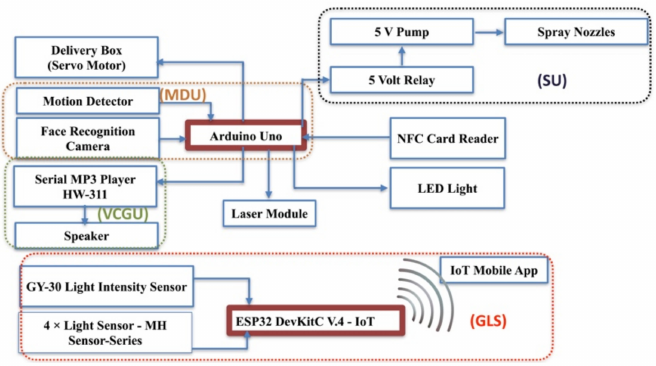
Figure 5. Medical delivery drone enhanced components for Guidance Landing